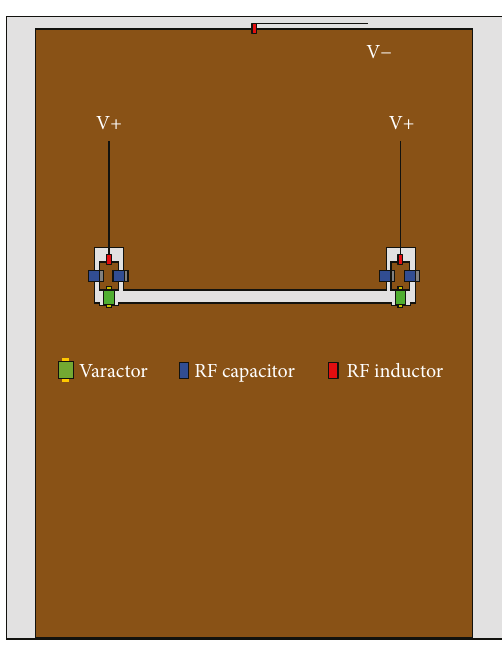
Figure 14: Biasing circuit con fi guration.